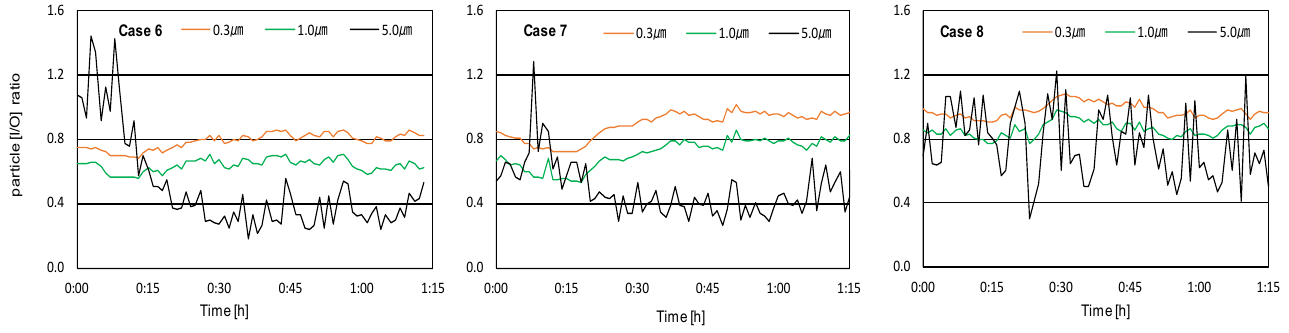
Figure 8. Particulate I/O ratios with a ventilation fan, natural ventilation, and an air conditioner (conditions 6–8). Table 4. The mean, median and standard deviation by particle size in each condition.